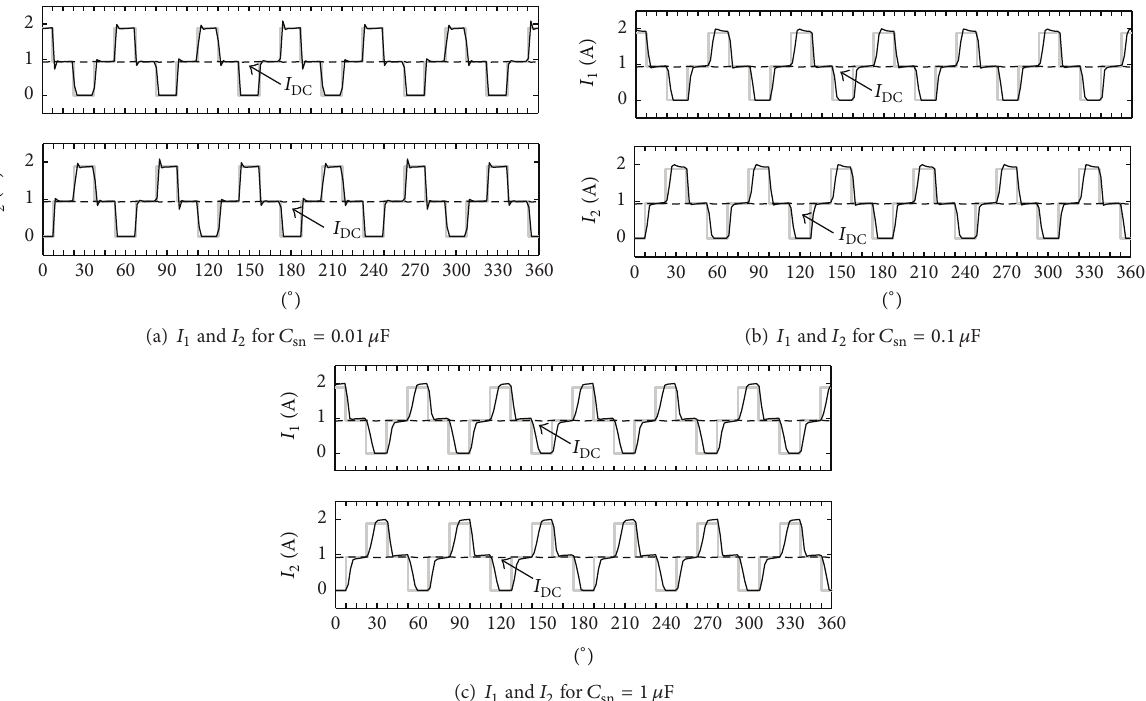
Figure 13: Simulated AC side current and DC bus waveforms for the 3-level thyristor based MLCR